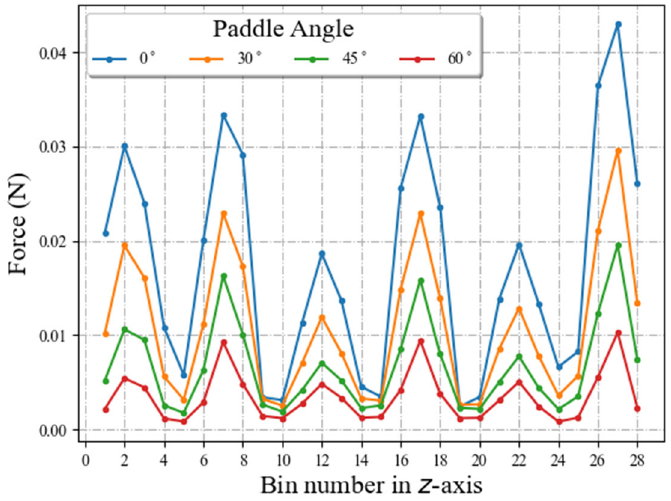
Figure 15. Time-averaged forces acting on particles in a line along z -direction for various paddle Figure 15. Time ‐ averaged forces acting on particles in a line along z ‐ direction for various paddle angle of 0 ◦ , 30 ◦ , 45 ◦ , and 60 ◦ angle of 0°, 30°, 45°, and 60°.